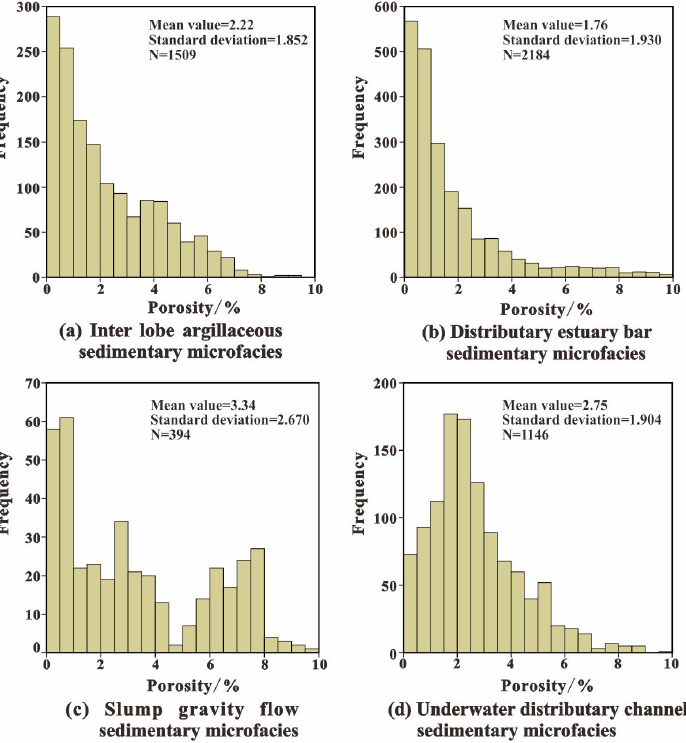
Figure 7. Distributions of logging porosity in different sedimentary microfacies (5235 logging porosity data from 675 m of 4 wells).